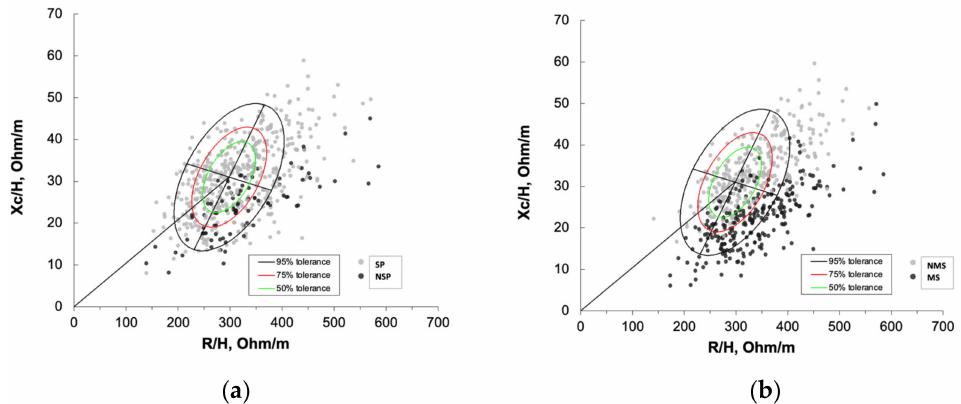
Figure 3. The distribution of impedance point vector of the admitted patients. Representing values of R/H and Xc/H in patients. ( a ) Green point, Survival patients (SP) and black point, non-survival patients (NSP). ( b ) Green point, Malnutrition status (MS) and black point, non-malnutrition status (NMS) using SPhA-malnutrition as a DRM diagnostic parameter. Bioelectrical values of malnutrition: survival patients (n = 484), non-survival (n = 86) and R: resistance (Ohm); Xc: reactance (Ohm); H: height (m); (R/H) and (Xc/H): R/H and Xc/H standardized for sex and age using bioelectrical Italian standards. The bioelectrical impedance vector distribution analysis shows a situation of inflammation and cellular injury associated with malnutrition. The lower right quadrant encompasses patients with decreased cell mass and hyperhydration, most of the deceased